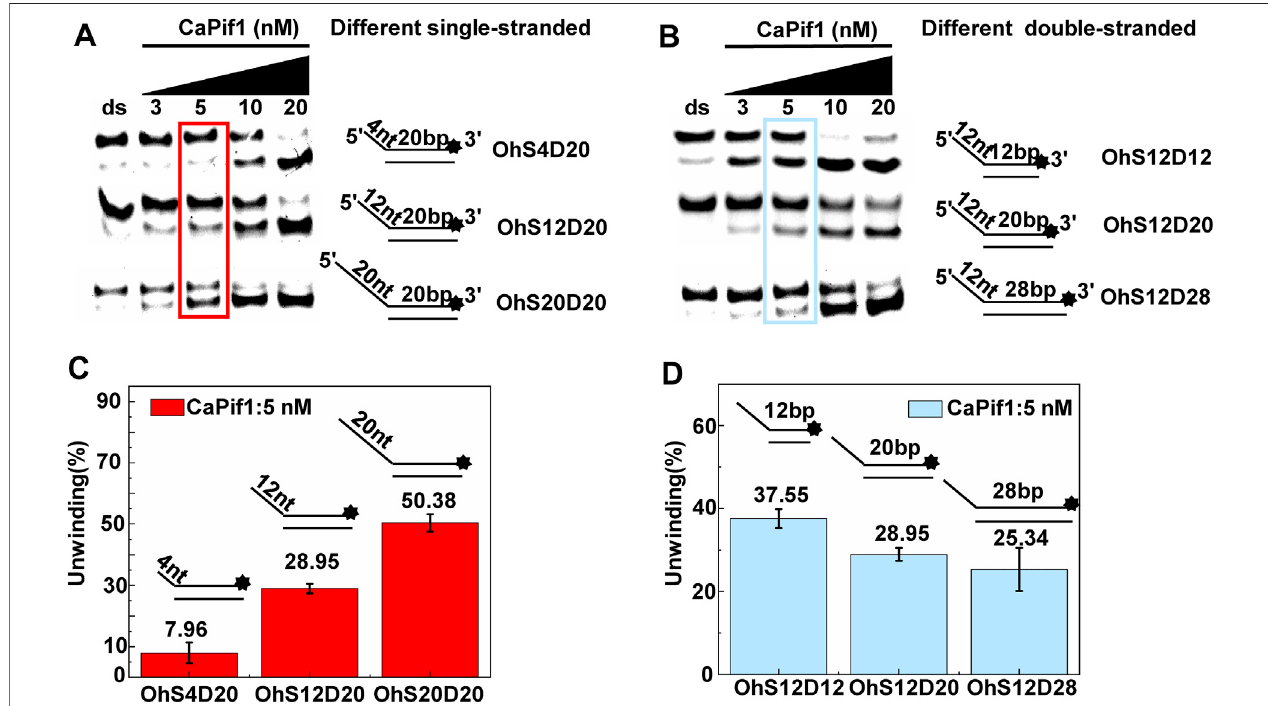
FIGURE3| ComparisonoftheunwindingactivityofCaPif1withDNAsubstrateswithdifferentlengths. (A) Aseriesof20-bpdsDNAsubstrateswithvaryinglengths of the 5 ′ -tailed duplex DNAs, from 4 to 20 nt. (B) The 12 nt tailed duplex DNAs with varying lengths of the duplex region (from 12 to 28 bp) (see Table 1 for substrate sequences). (C – D) The bar chart based on the unwinding ratio of at 5 nM CaPif1 by scanning gray values with Image Lab software (Supplementary Table S2) . All experiments were performed under standard experimental conditions as described in “ Materials and